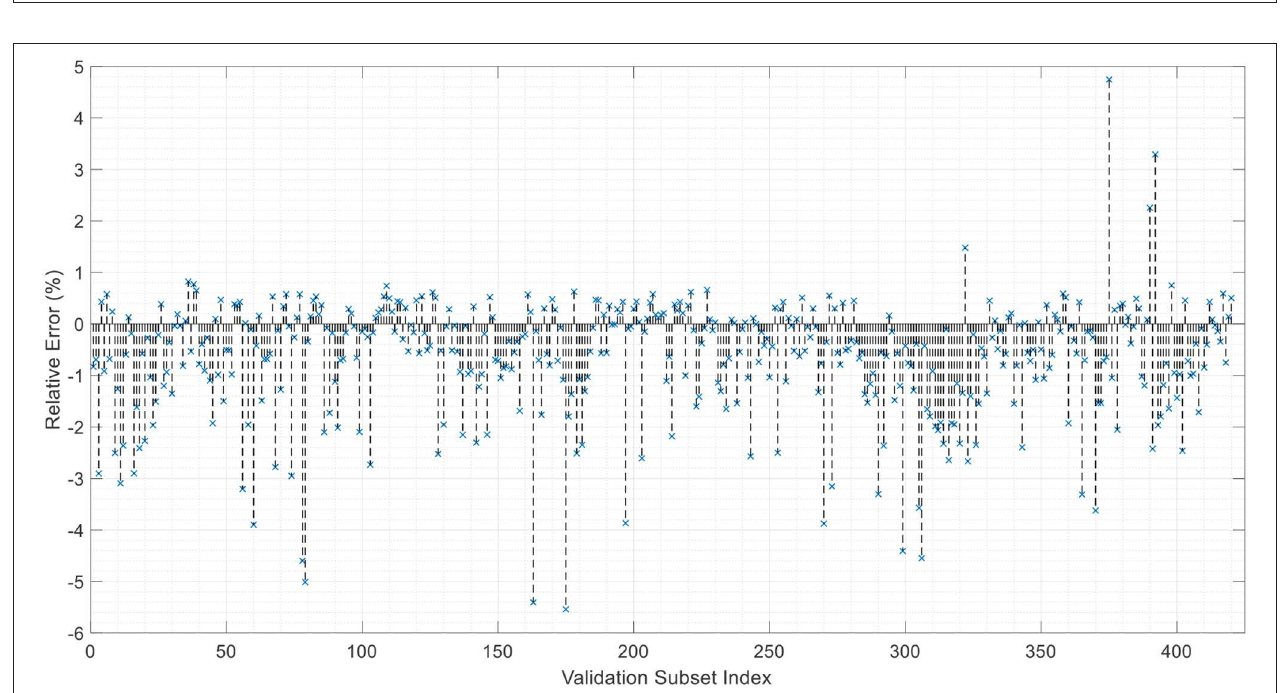
FIGURE 5 | Schematic of predicted and measured firebrand mass